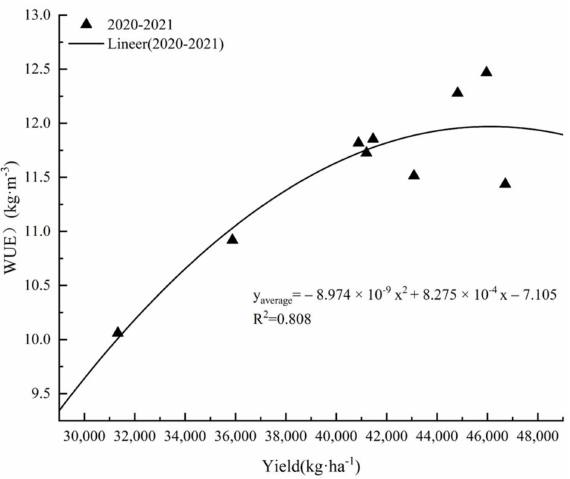
Figure 5. Relationship between yield and water use efficiency of pumpkins.